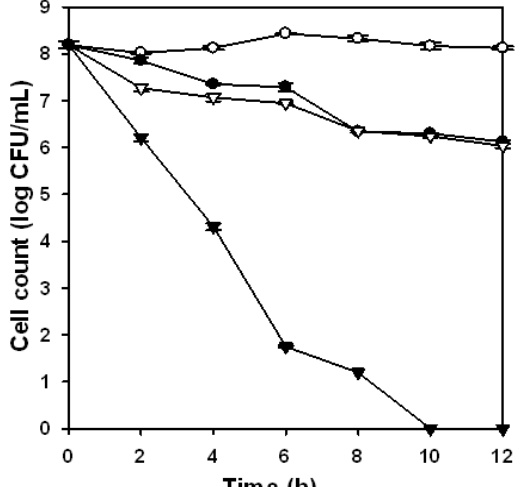
Figure 2. Effect of water-soluble chitosan derivative (GN70-3) at the concentration of 250 mg/L on antibacterial activity of S. aureus in deionized water and 0.85% saline solution up to 12 h. S. aureus was cultured in either deionized water ( ▼ , ▽ ) or saline solution ( ● , ○ ) at 37 °C. Open symbols ( ▽ , ○ ) indicates cells without chitosan treatment, while solid symbols ( ▼ , ● ) indicated cells with chitosan treatment. Each value is expressed as mean ± SD (n =